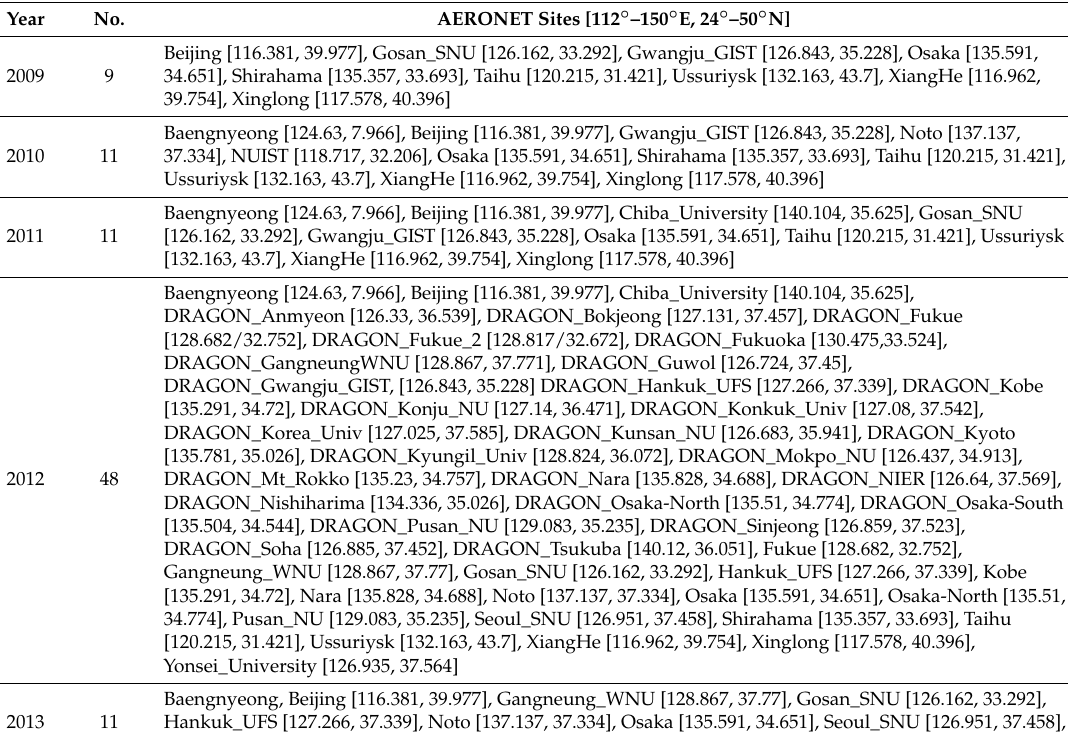
Table 5. Information of AERONET sites for the validation of retrieved AOD from TANSO-CAI aerosol algorithm [62].